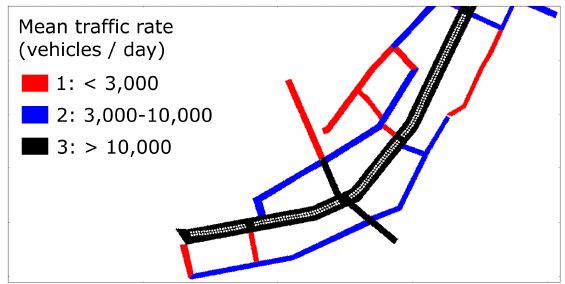
Figure 5. The particle source area (in colours) in the block-design alternatives V par and V parJJ . Source areas are divided into groups 1, 2 and 3 based on the estimated mean traffic rates in year 2025 (see legends). Street surfaces below trees (white dots) are omitted as source areas. Orientation as in Figure 2. Particles are released at a constant rate of 0.25 m − 2 s − 1 within each 1 m × 1 m × 1 m source grid box. No particles are released below the street trees. The street network is divided into three